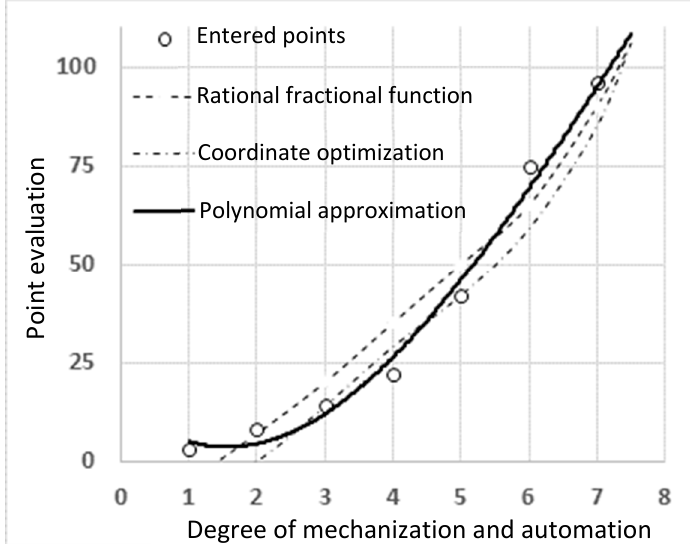
Figure 6. Graphical evaluation of the results of approximation of the point evaluation at the degree of automation. Source: authors.